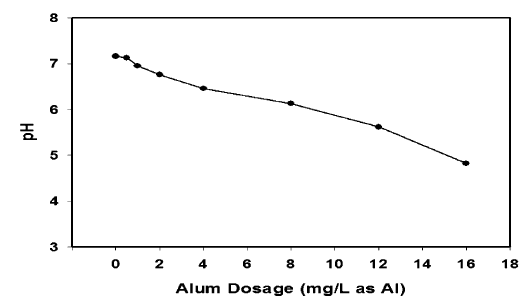
Fig. 5 pH values of supernatants under various alum